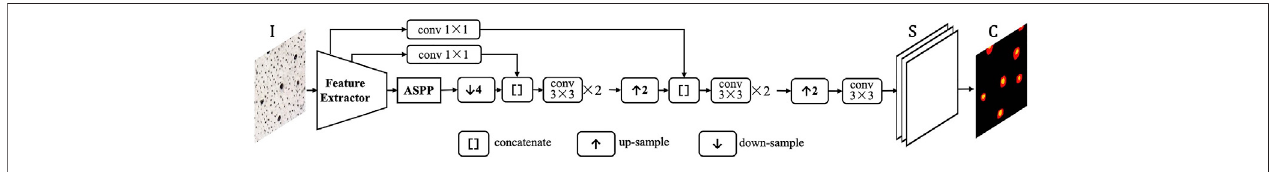
FIGURE 2 | Deep CNN structure for fossil osteon segmentation.